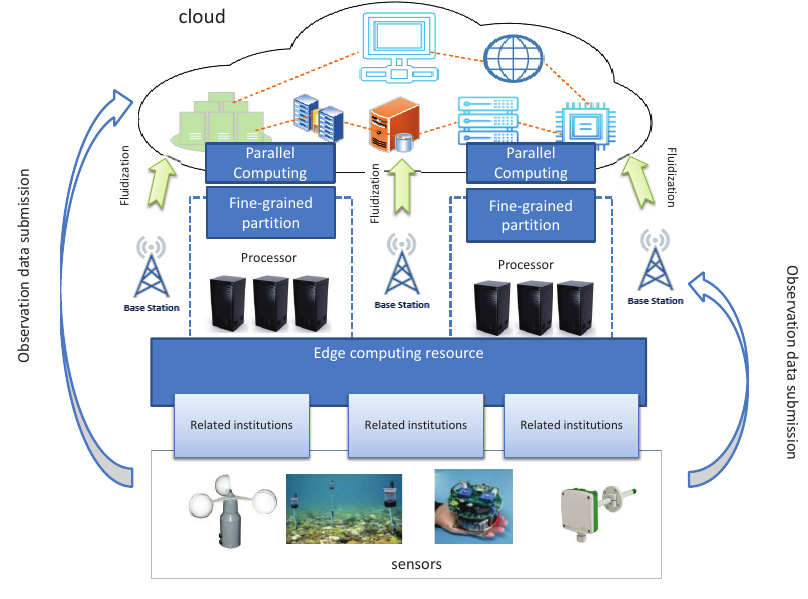
Figure 2. Edge computing empowered MVFD processing framework.